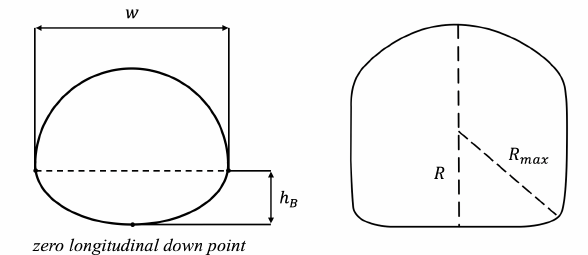
Figure 2. The definitions of flatness and